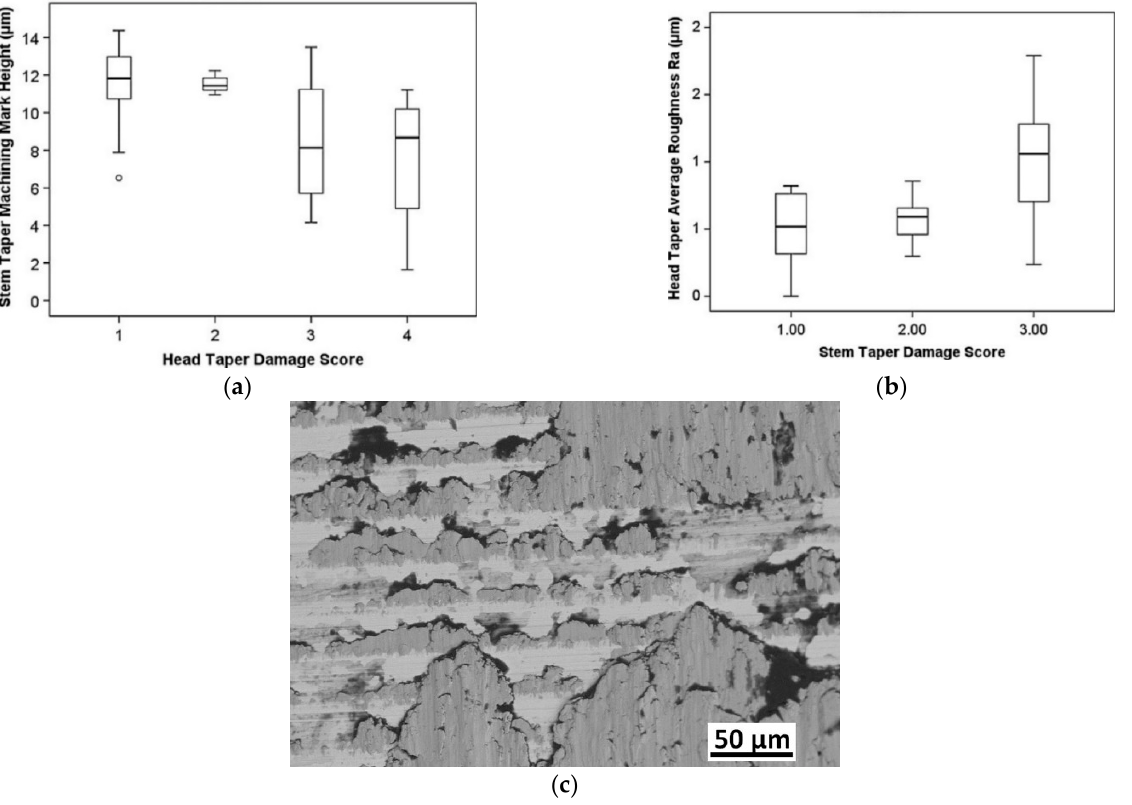
Figure 7. Influence of surface roughness on the damage score observed and measured in Pourzal et al. [39]: ( a ) CoCr–CoCr and ( b ) CoCr–Ti. ( c ) Backscatter mode of SEM on CoCr surface in a CoCr– Ti junction; the CoCr surface (bright areas) includes some Ti (dark areas) transferred from the trun- nion.